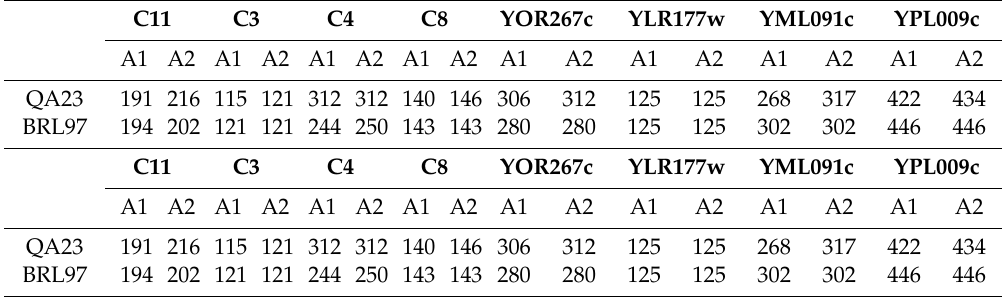
Table A2. Multilocus genotypes of two commercial S. cerevisiae strains. Numbers represent the fragment lengths of allele 1 (A1) and allele 2 (A2) at eight microsatellite